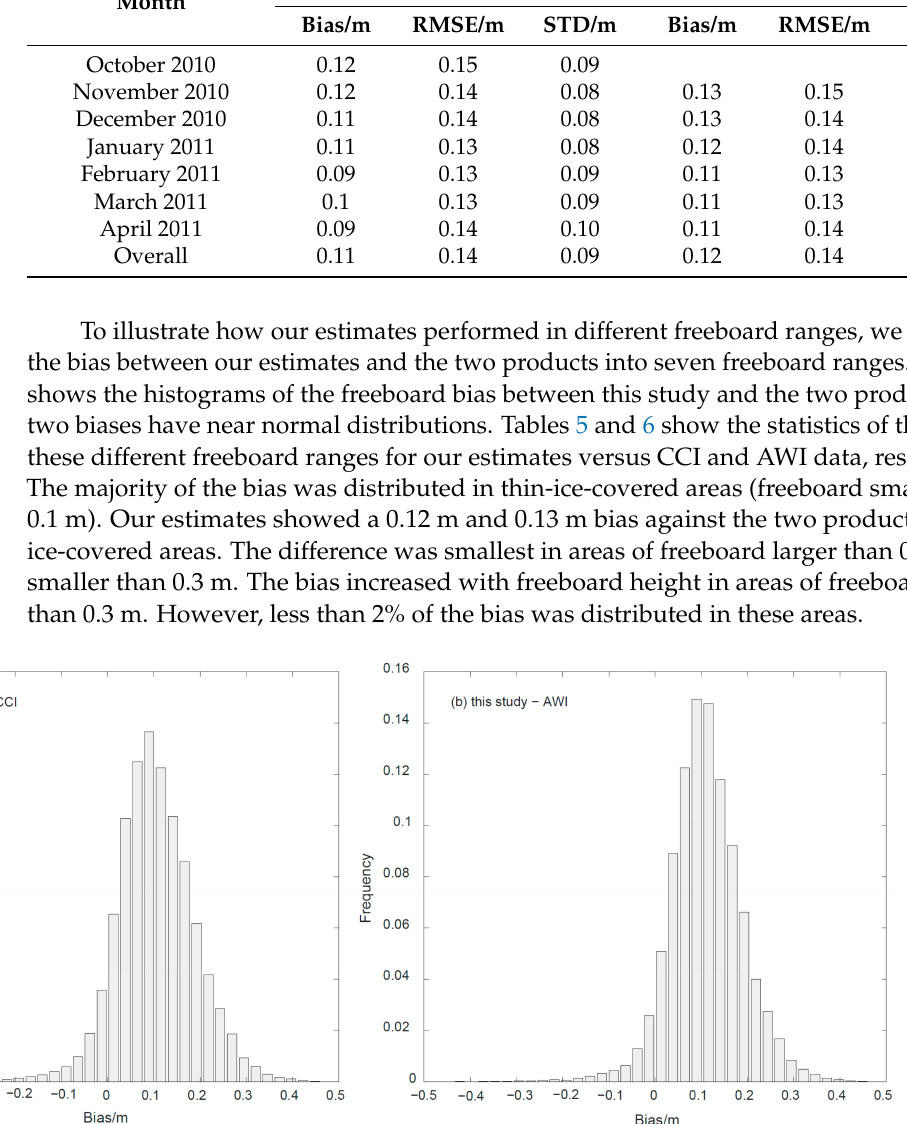
Figure 8. Histograms of the freeboard bias between this study and the two products, ( a ) this study and CCI, ( b ) this study and